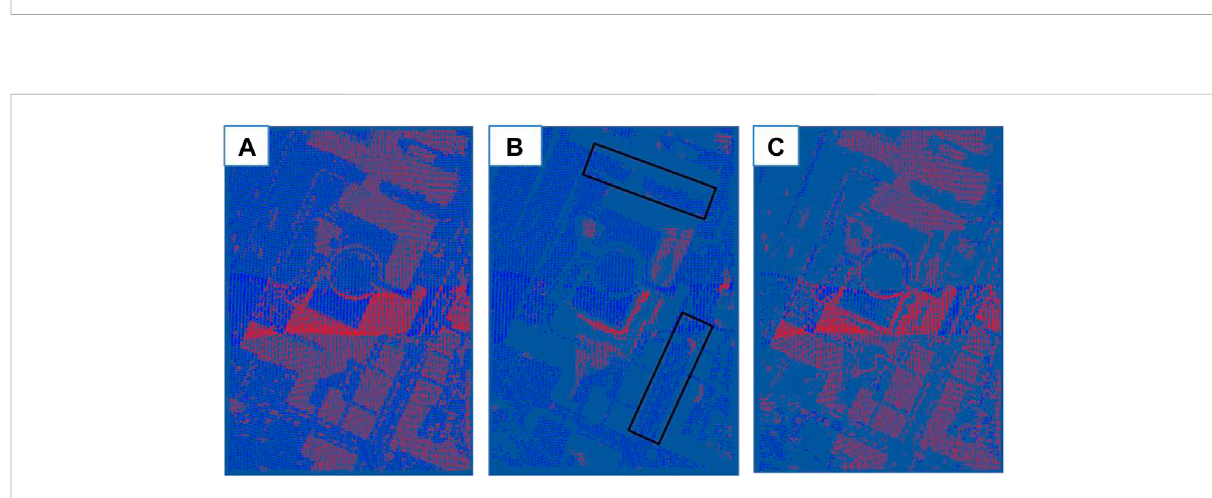
FIGURE 12 Filtering results for sample 11: (A) initial point cloud; (B) fi ltered point cloud (blue points), red points are the type Ⅰ error; (C) fi ltered point cloud (red points), blue points are the type Ⅱ error.